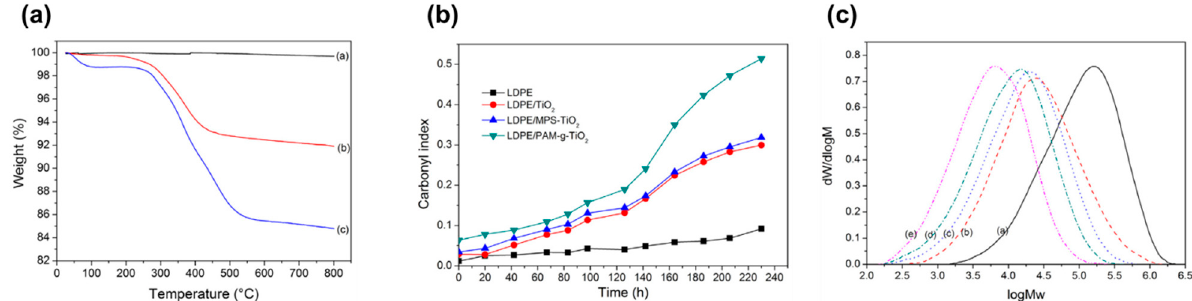
Figure 16. Photodegradation of PE-PAM-g-TiO 2 film. ( a ) Thermogravimetric analysis of TiO 2 (curve A), MPS-TiO 2 (curve B), and PAM-g-TiO 2 (curve C). ( b ) The carbonyl index of various samples under UV irradiation. ( c ) Molecular weight distribution of films LDPE (curve A), LDPE-UV (curve B), LDPE/TiO 2 -UV (curve C), LDPE/MPS-TiO 2 -UV (curve D), and LDPE/PAM-g-TiO 2 -UV (curve E) with irradiation time of 520 h [77]; reprinted from [77] with permission from Elsevier.